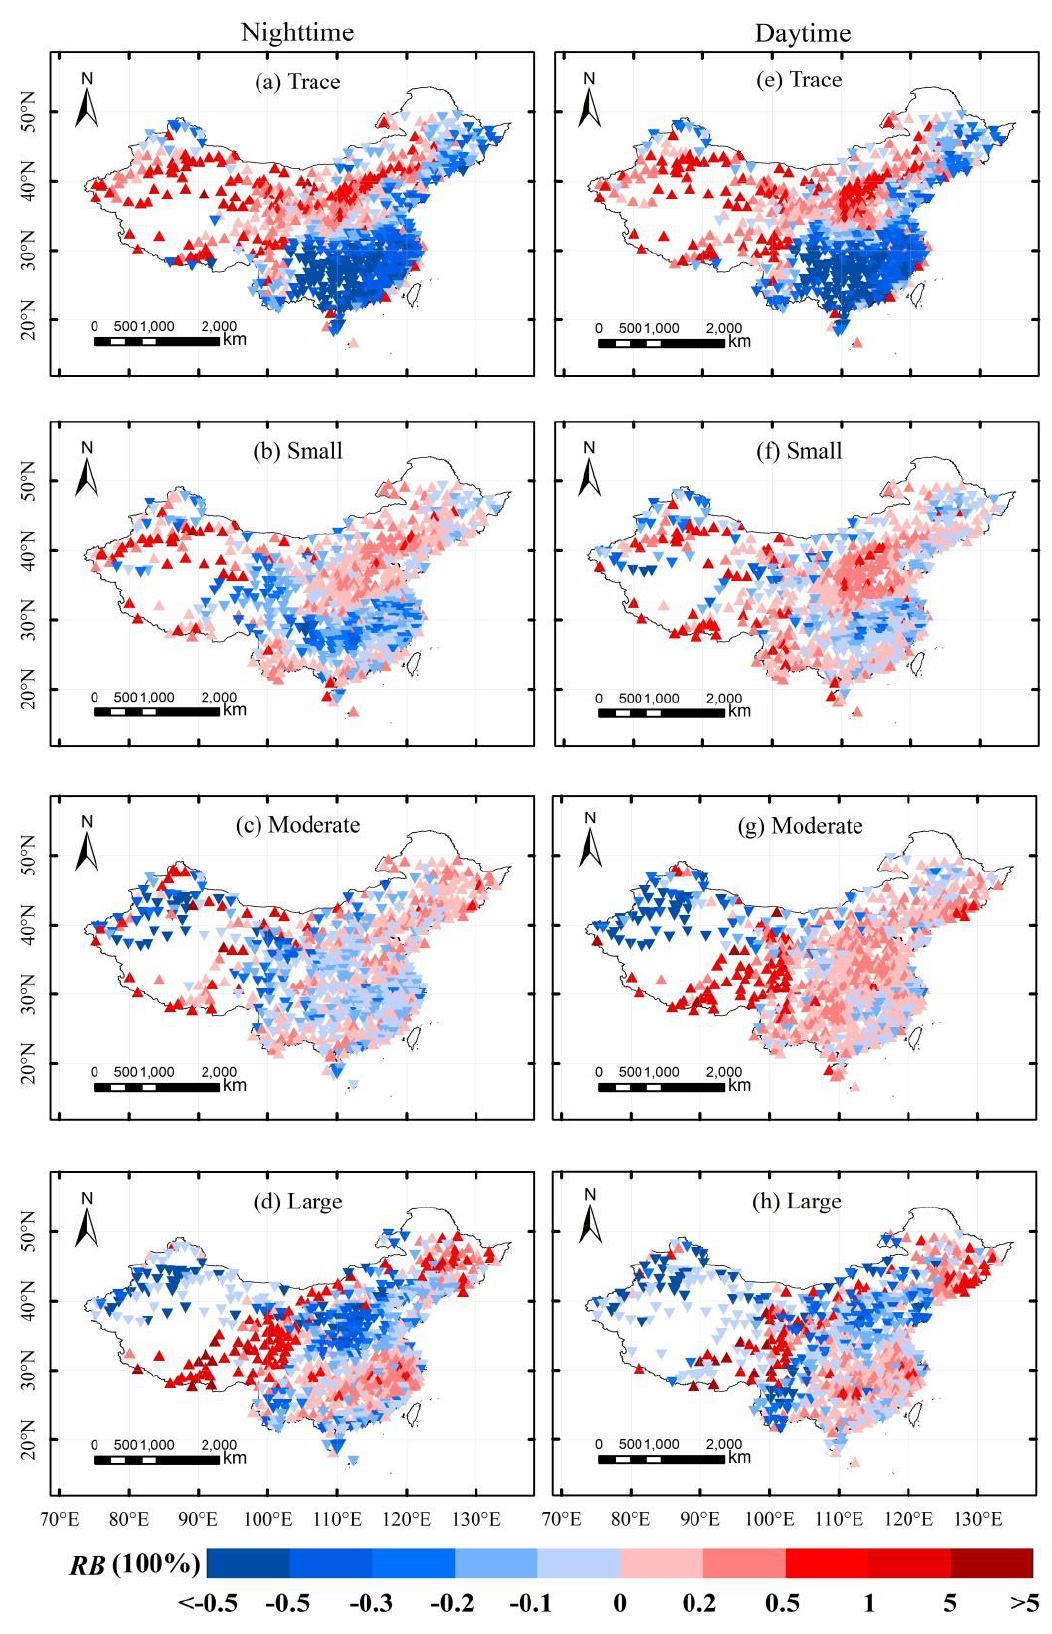
Figure 10. As in Figure 8, but for the amount of precipitation.